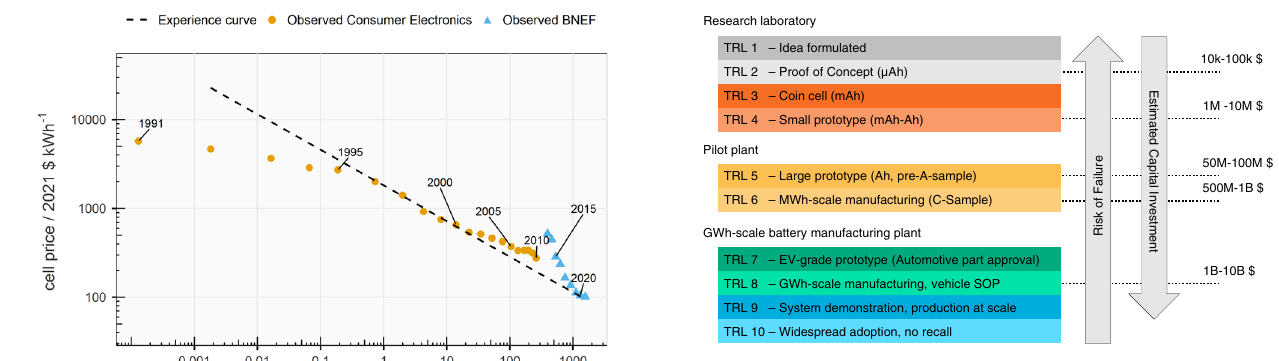
Fig.2|TechnologyreadinesslevelscaleforEVbatteryapplication. The “ Riskof Failure ” arrow indicates risks of project failure or technology not transitioning to the nextlevel. The scalestarts with lab innovation and considers key milestones in cellmanufacturing toreachEV quali fi cation and vehicle Start-of-Production(SOP). Thede fi nitionsofA-andC-samplesarediscussedlaterinthe “ Challengesinscaling up ” paragraph. Risk increases with decreasing TRL number. US dollar fi gures are ballpark estimates of the minimum investment required per project based on industrial data or publicly available press releases. The present TRL scale is based on the consideration of energy storage innovation disclosed in ref. 198